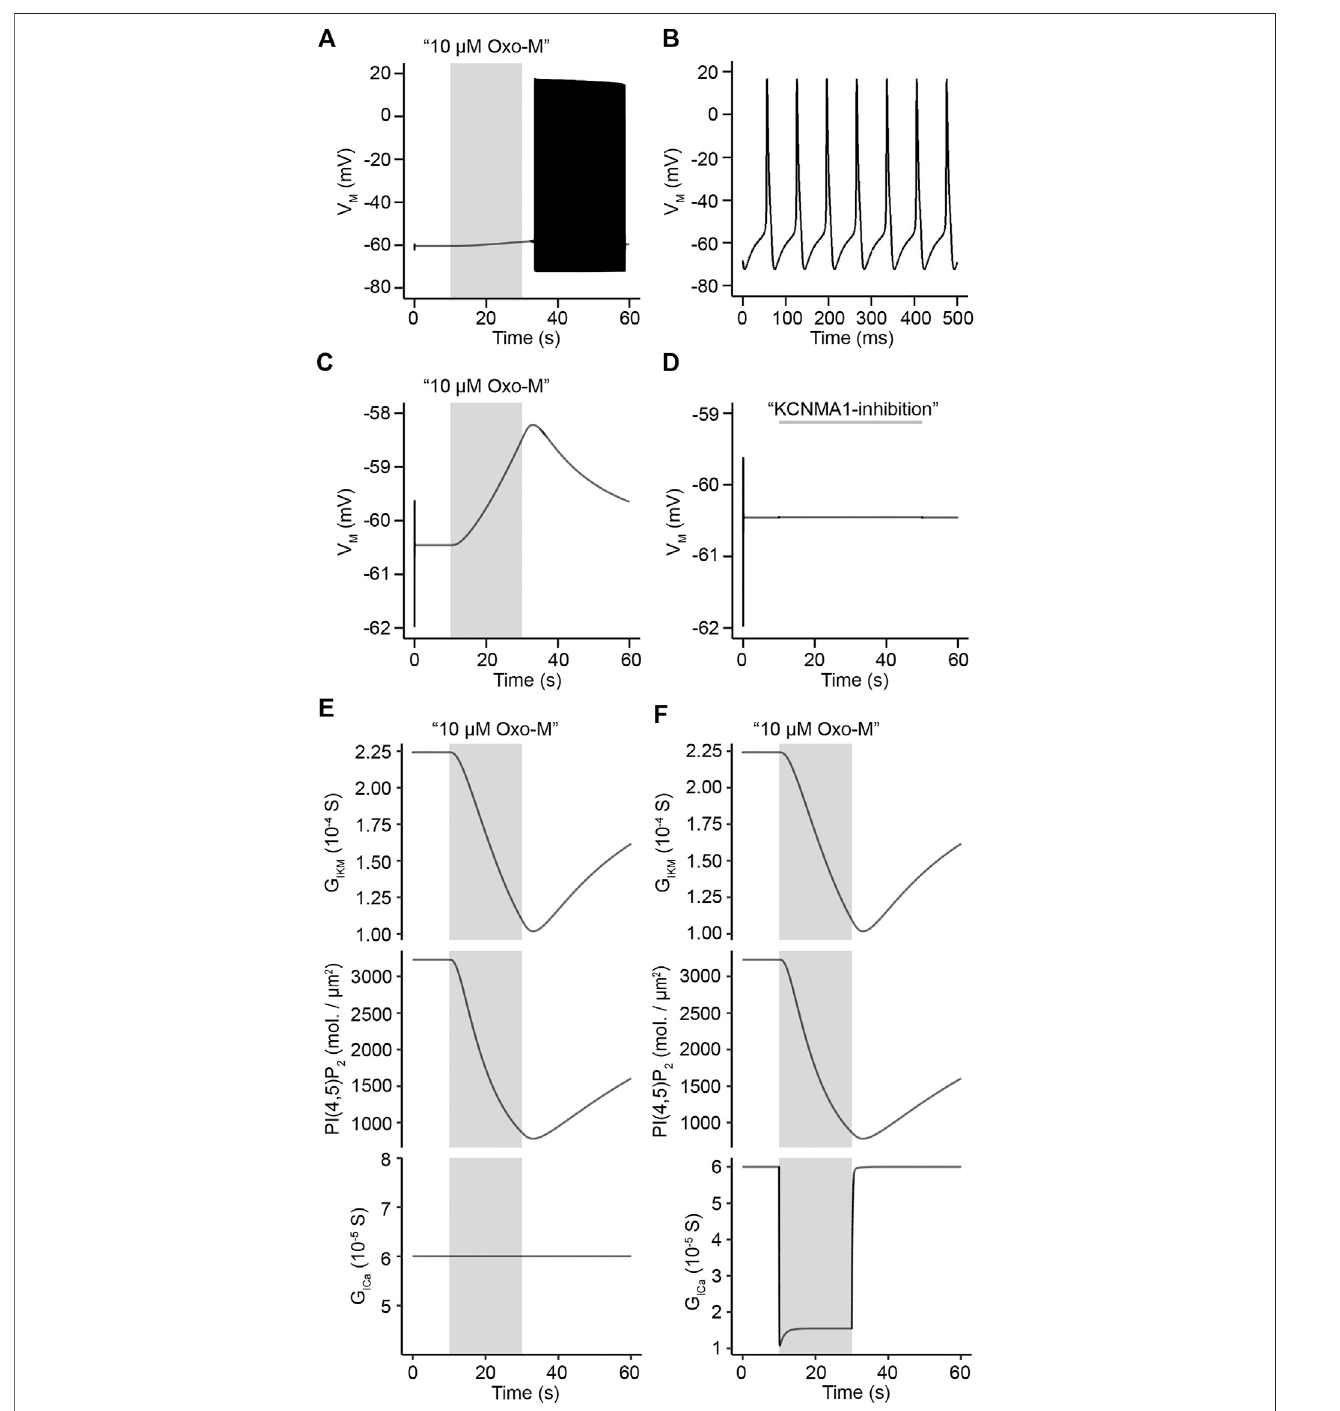
FIGURE 3 | Evaluation of model of action potential fi ring in rat superior cervical ganglion neurons. (A) . Simulated membrane potential of rat SCG neurons in response to stimulation with 10 μ M Oxo-M for 20 s. (B) . Simulated action potentials representing time period from 40.0 s to 40.5 s in simulation shown in A. (C) . Simulation of change in membrane potential to a 20 s application of 10 μ M Oxo-M (top panel) under a condition of maximum L-type channel conductance over the entire simulation period. (D) . Simulated membrane potential ofrat SCG neurons over 60 s in response to 100% inhibition of KCNMA1 channel activity from 10 s to 50 s of the simulation. (E) . KCNQ2/3 channel conductance (top panel) , and PI(4,5)P 2 density (middle panel) under a condition of maximum L-type channel conductanceovertheentiresimulationperiod (bottompanel) . (F) .SameasinE,butallowingformodi fi cationofL-typechannelconductanceinresponsetostimulation with Oxo-M (bottom panel)